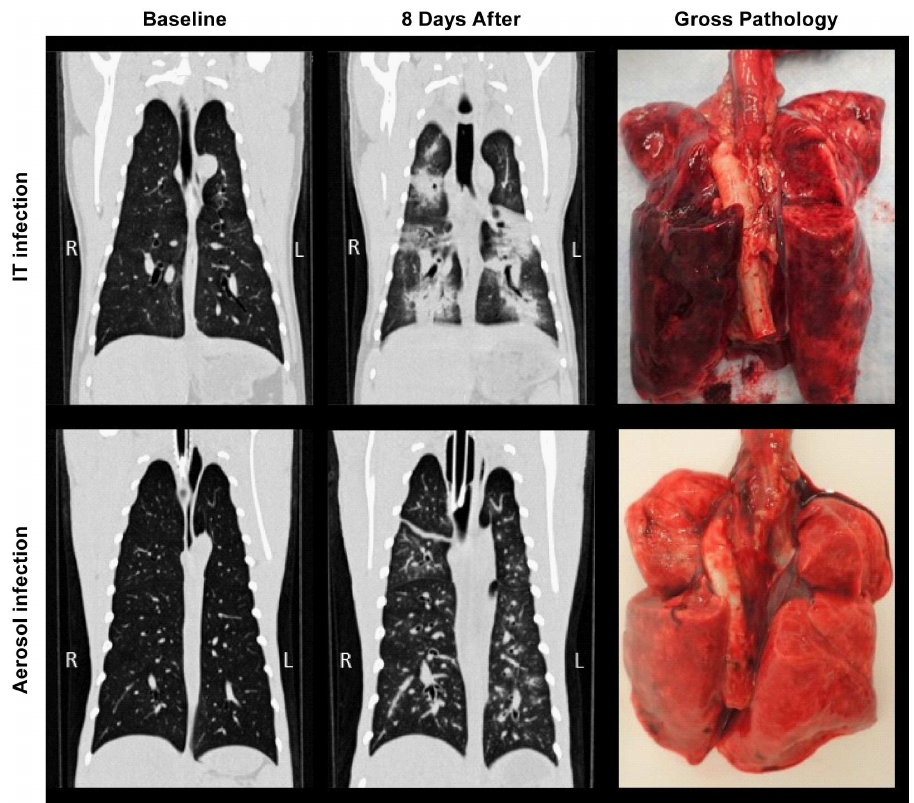
Fig 6. Comparison of CT evaluation of lungs with gross pathology from NiV infected animals. Gross pathologic assessment was in agreement with CT images, indicating severity was often greater in the caudodorsal lung lobes of both models. Extensive lung congestion, hyperemia and multifocalareas of consolidation were more likely to be observed using the IT route of infection, whilethe aerosol model exhibited mildly congestedareas with multifocalareas of hemorrhage. Tracheal mucosa was typically found to be congested,edematous and often